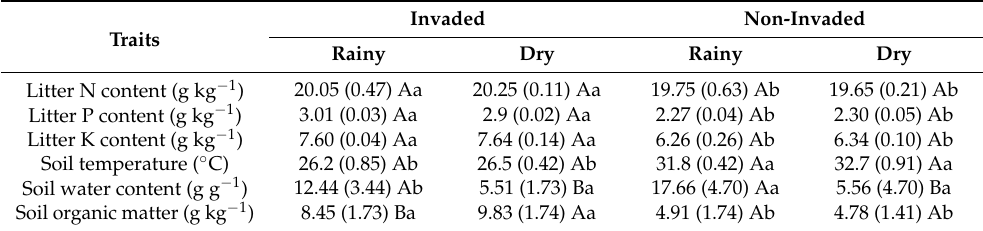
Table 3. Litter quality (N, P, and K contents, g kg − 1 ), soil temperature, soil water content, and soil organic matter (mean ± SD) in both invaded and non-invaded environments during the rainy and dry seasons in a tropical Cambisol, Caatinga ecoregion, Paraiba, Brazil. Invaded Non-Invaded Traits Rainy Dry Rainy Dry Litter N content (g kg − 1 )